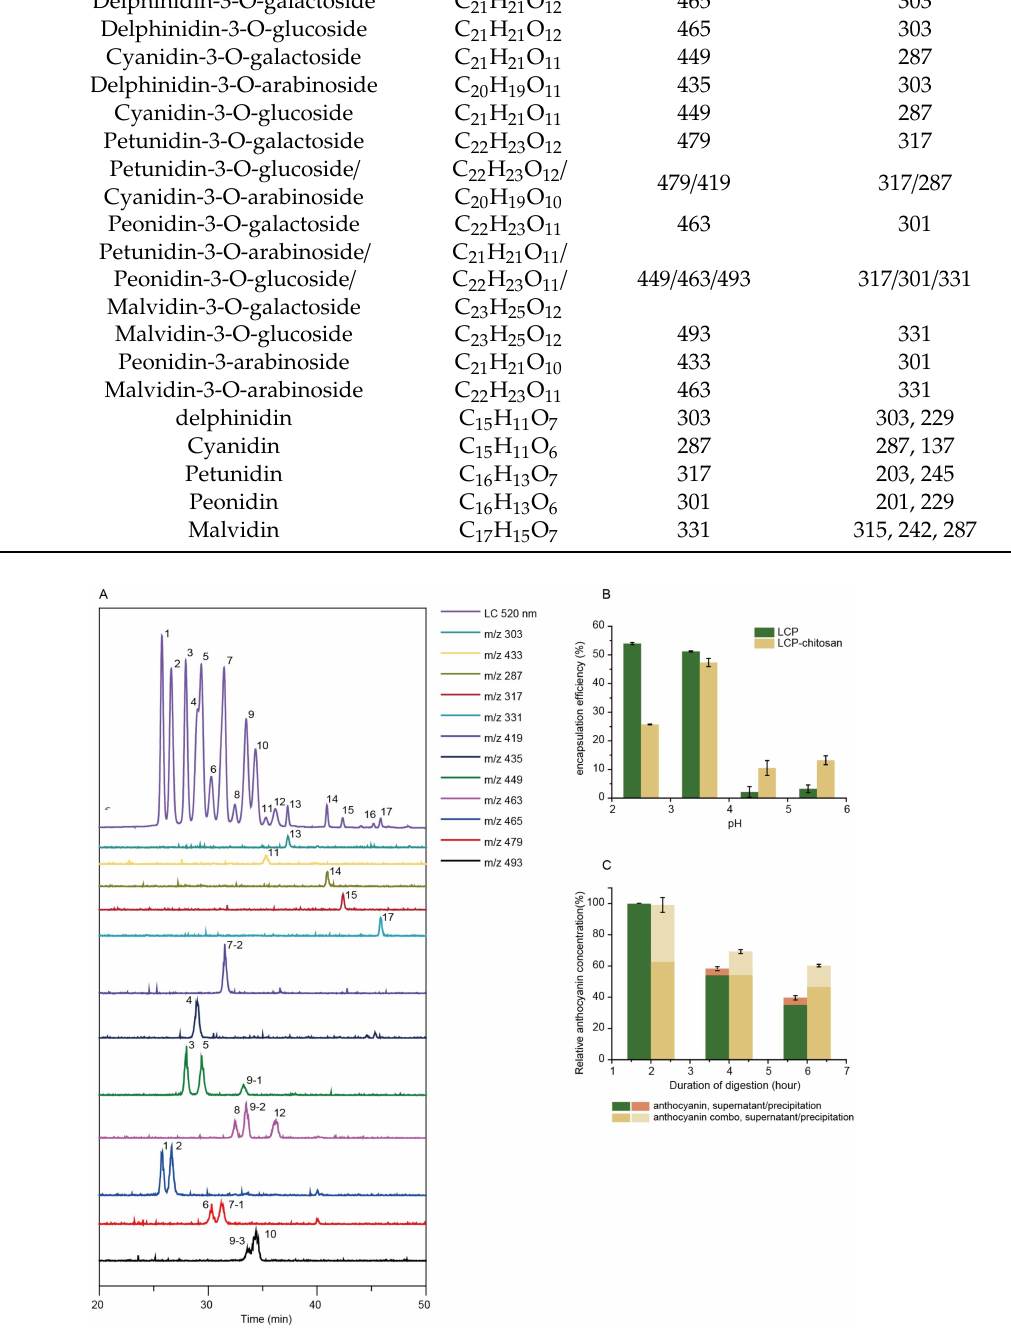
Figure 1. Main components and digest stability. ( A ) High-performance liquid chromatography–ultraviolet-visible spectroscopy-tandem mass spectrometry (HPLC-UV / vis-MS / MS) chromatograms (detected at 520 nm) of bilberry extracts. ( B ) Chitosan and low molecular citrus pectin (LCP) fabricated polyelectrolyte complexes at di ff erent pHs. ( C ) Relative content of anthocyanins of bilberry extracts and anthocyanin combo (anthocyanin–LCP–chitosan) in simulated gastric fluid (SGF) with pepsin at pH 2.0 for 2 h ( A ) and subsequently in simulated intestinal fluid (SIF) with pancreatin at pH 6.8 for 4